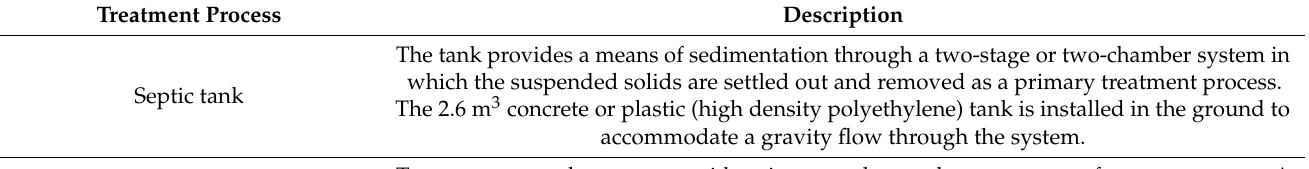
Table A1. Brief descriptions of different on-site treatment processes in DWWTS (further design details are available and based on the EPA’s code of practice